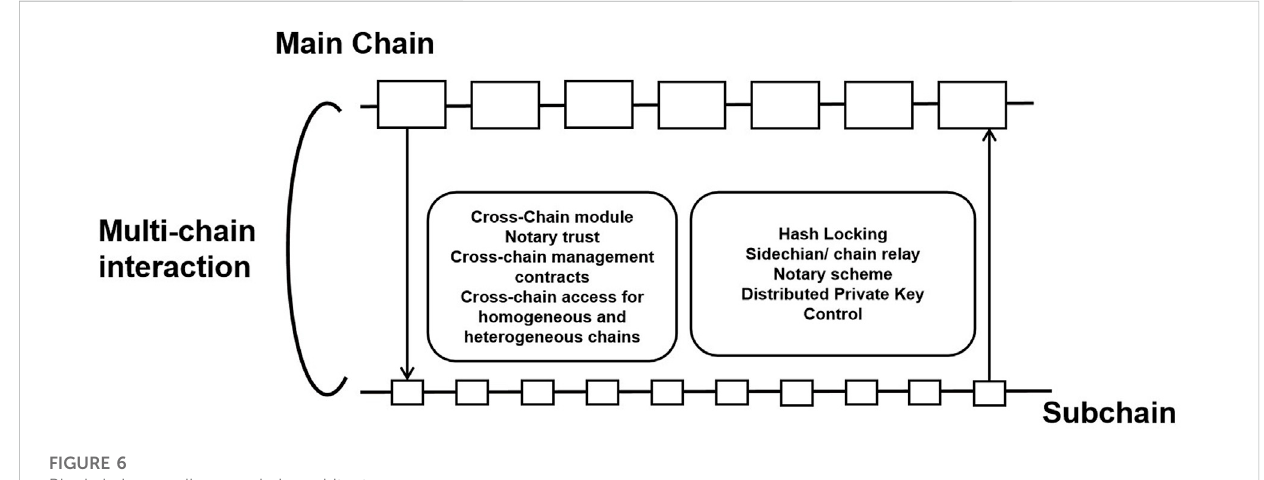
FIGURE 6 Blockchain overall cross-chain